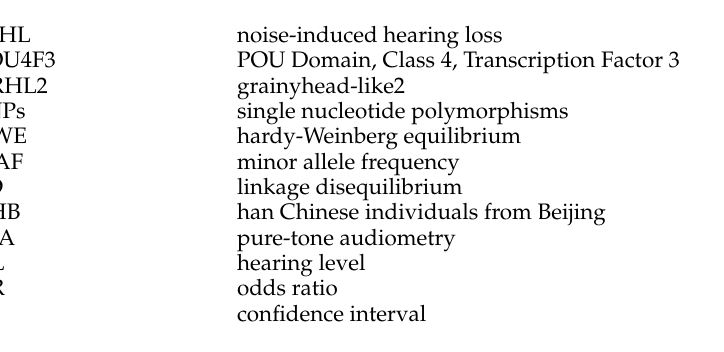
Table S1: Demographic and general characteristics of case and control subjects, Table S2: Associations of candidate SNPs with the risk of NIHL, Table S3: Linkage disequilibrium test of GRHL2